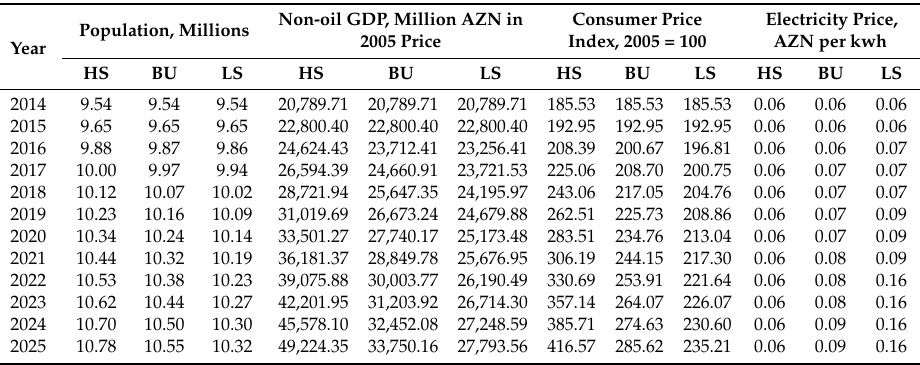
Table 9. Projected values for the explanatory variables.